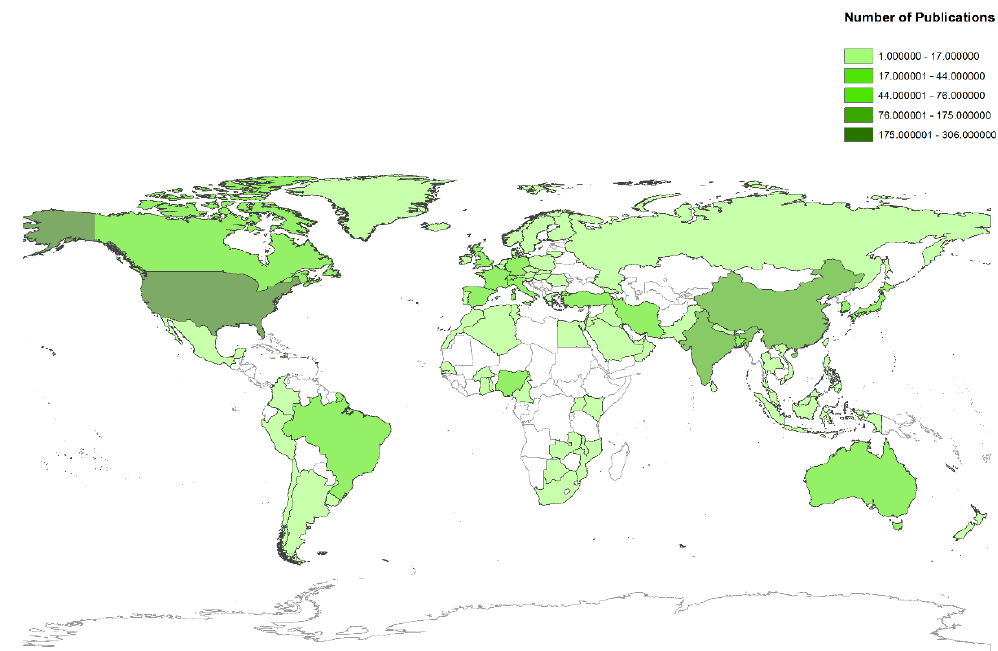
Figure 3. Geographical distribution and frequency of published articles relating to groundwater contamination (January 1975 – September 2017).